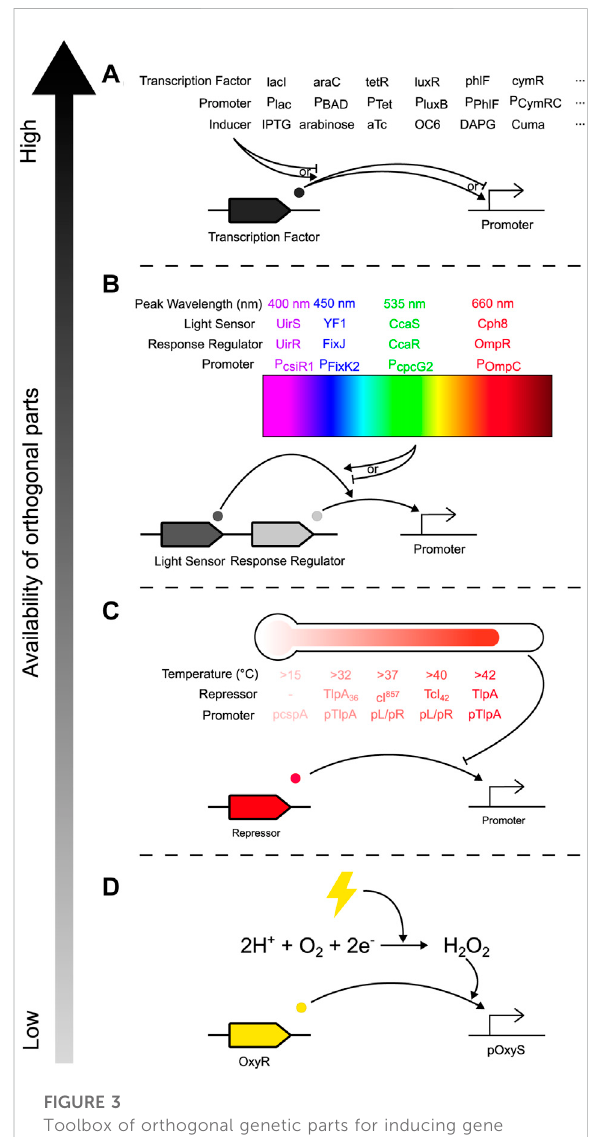
FIGURE 3 Toolbox of orthogonal genetic parts for inducing gene expression in bacterial communities, arranged by availability of orthogonal parts from highest to lowest. Common examples from each input method are depicted, but this is not an exhaustive list, and other mechanisms and implementations are possible for each method. (A) Chemically induced promoters, where expression of a gene of interest (GOI) is activated/inhibited by a transcription factor, which is itself activated/inhibited by exogenous addition of a chemical inducer. (B) Optogenetic regulators (here illustrated by two-component systems), where a light-sensing protein is reversibly changed after exposure to particular wavelengths of light and activates a response-regulating transcription factor that activates expression of a GOI. (C) Temperature sensitive promoters, which are typically repressed by a transcription factor whose activity is diminished past a certain temperature, activating expression of a GOI. (D) Peroxide inducible promoters which respond to electrical inputs. Application of electricity to the environment reduces dissolved oxygen to hydrogen peroxide, which activates the OxyR transcriptional activator, thus enabling expression